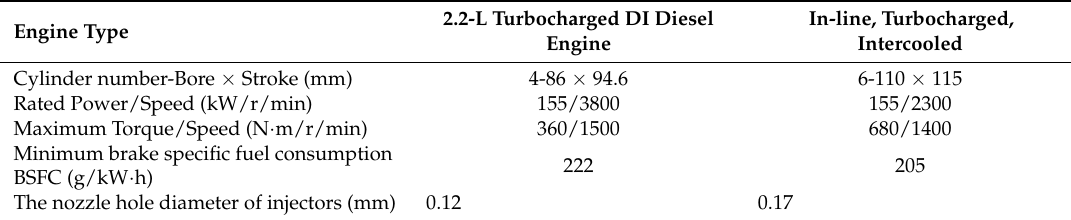
Table 3. Comparison of injector nozzle hole diameter of commercial diesel engine.